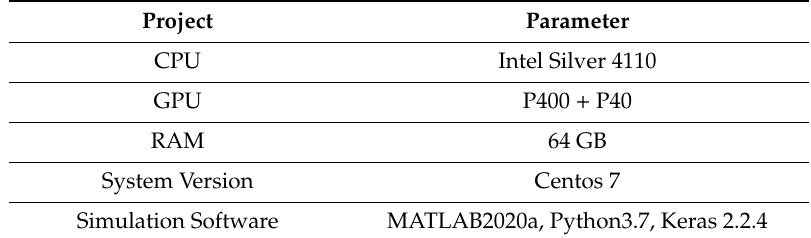
Table 1. Experiment platform parameters.